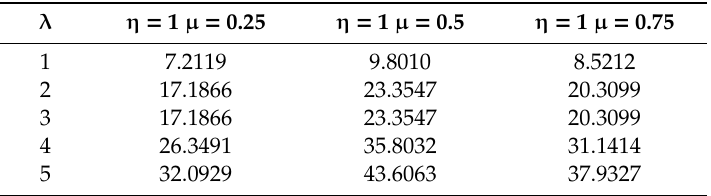
First five natural frequencies for the UD distribution for three di ff erent states of complete agglomeration.